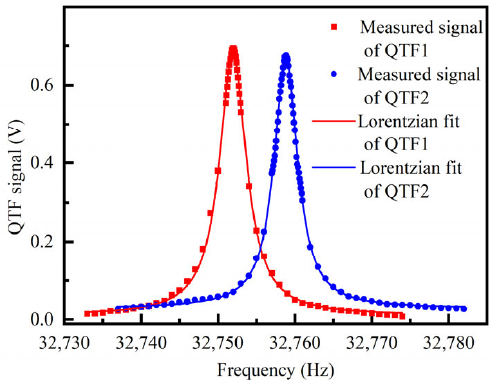
Figure 2. Response frequency curve of two QTFs measured by the electrical excitation method. Table 1. Measurement parameters of QTFs. QTF No.